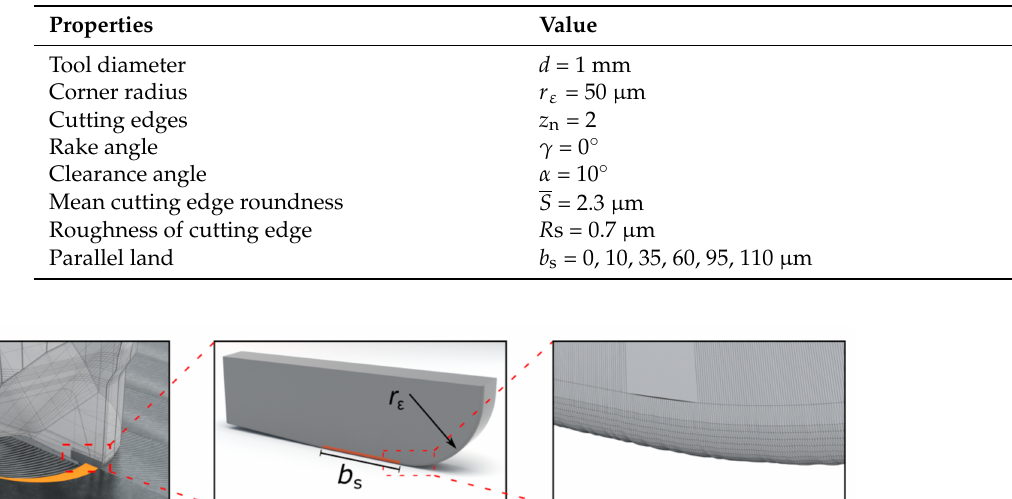
Table 1. Parameters of the modelled tools with various wiper lengths.